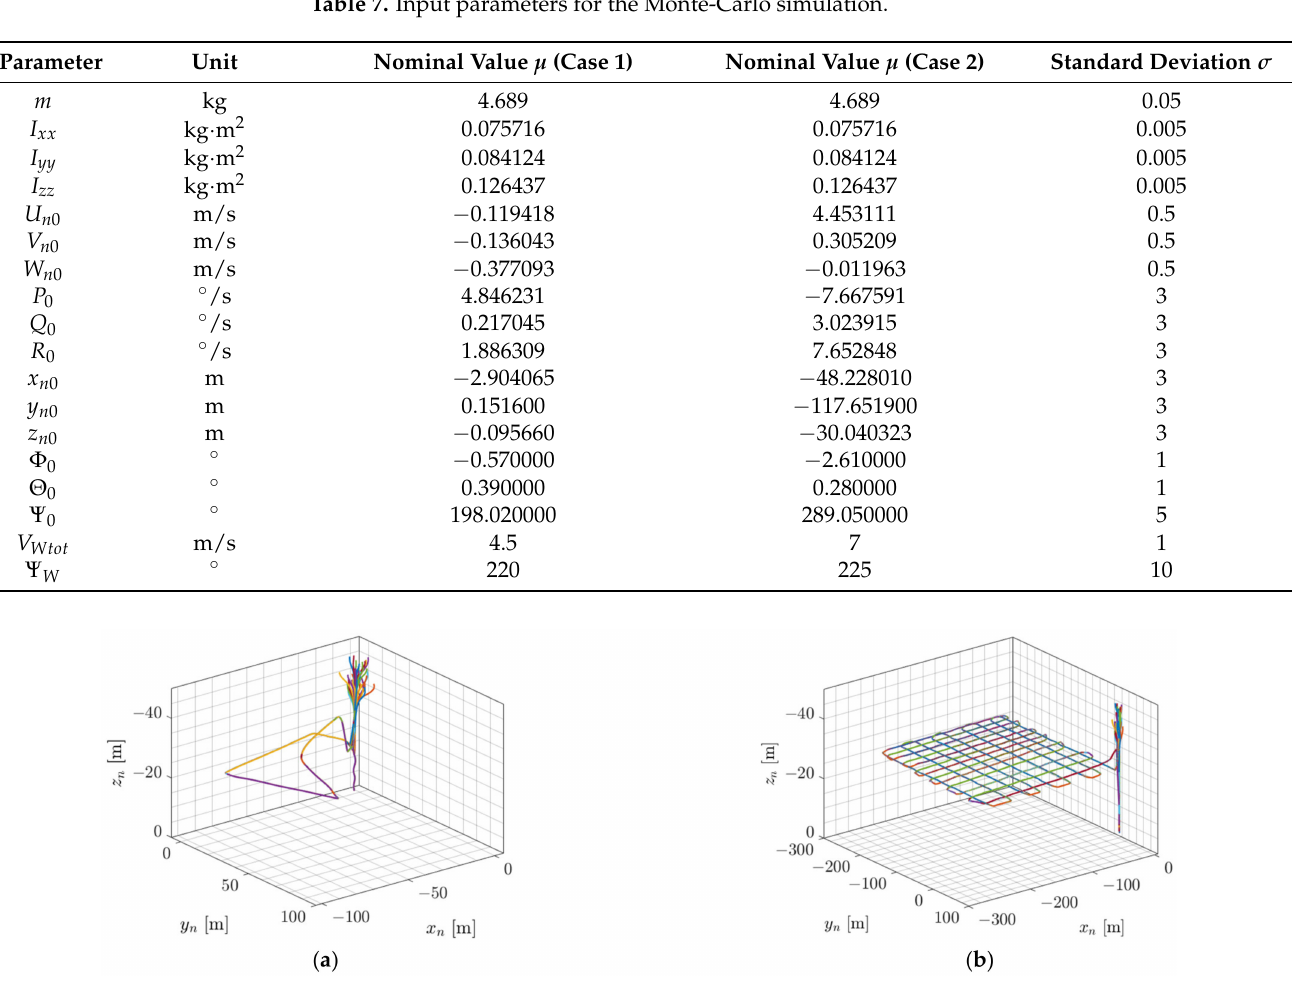
Table 7. Input parameters for the Monte-Carlo simulation.